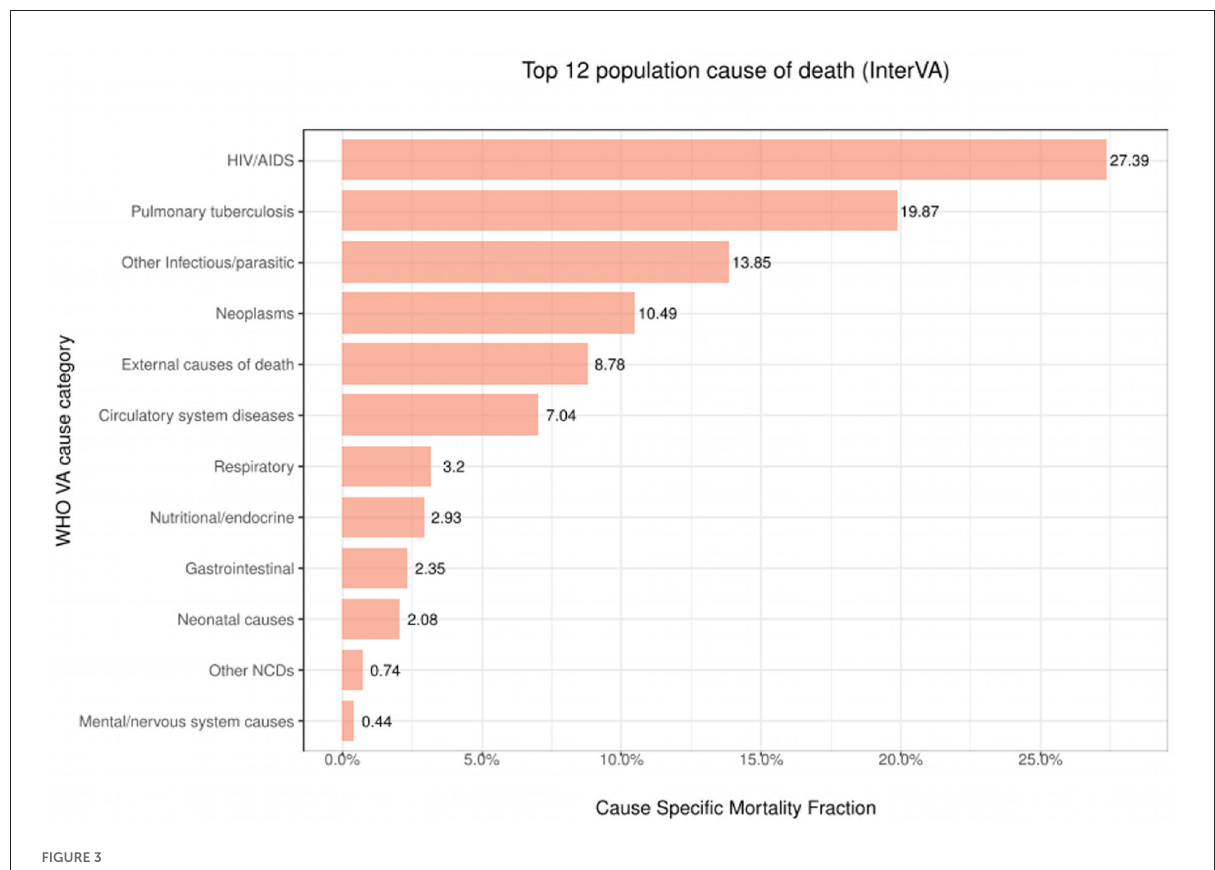
FIGURE3 Top 12 CoD